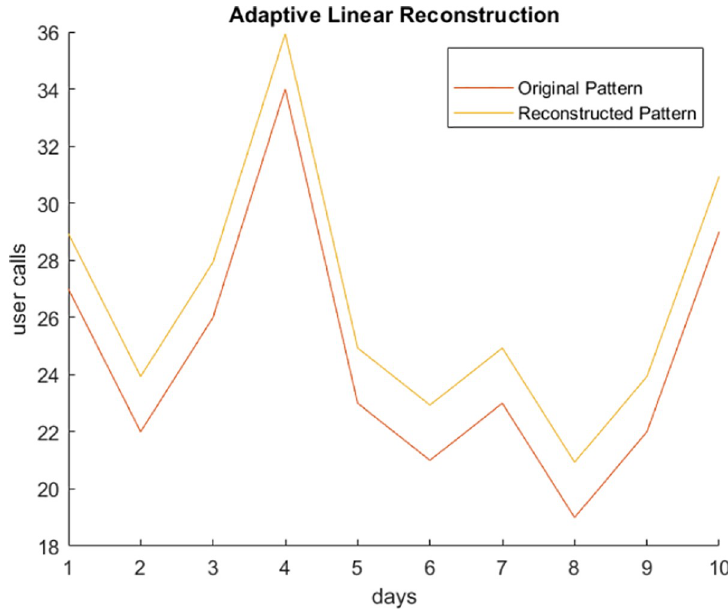
Fig 13. Plotting original and reconstructed curves in adaptive privacy distribution (low